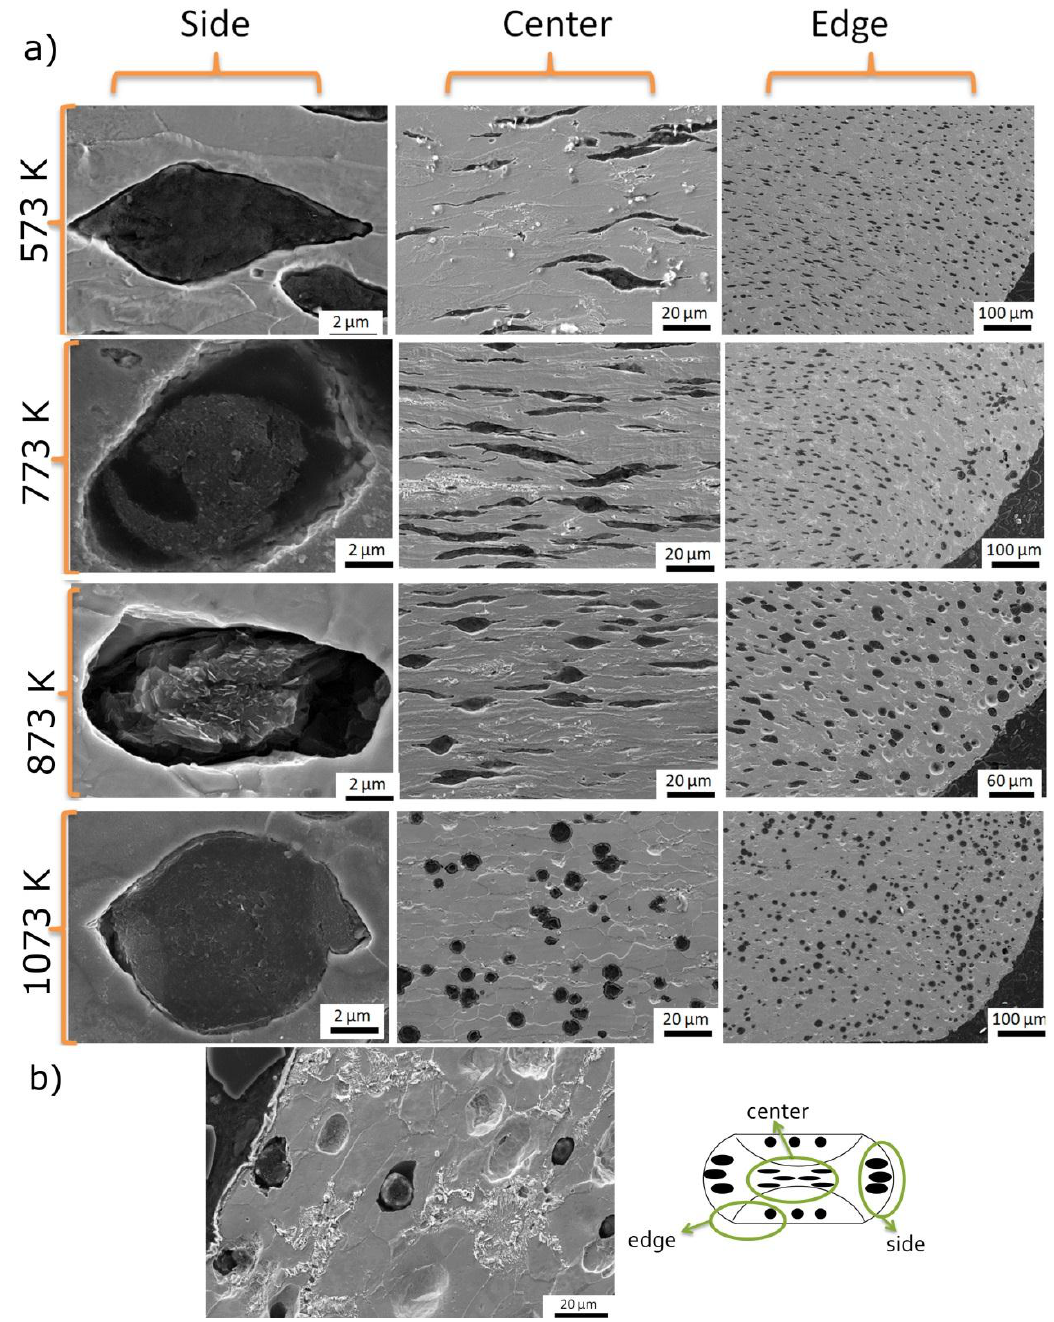
Figure 4. ( a ) Microstructures and damage after compression tests in the stress direction for temperatures of 573 K (ε p = 0.40), 773 K (ε p = 0.65), 873 K (ε p = 0.56) and 1073 K (ε p = 0.60). ( b ) Deformation and damage in the direction transverse to the stress direction after compression tests carried out at 873 K (ε p =